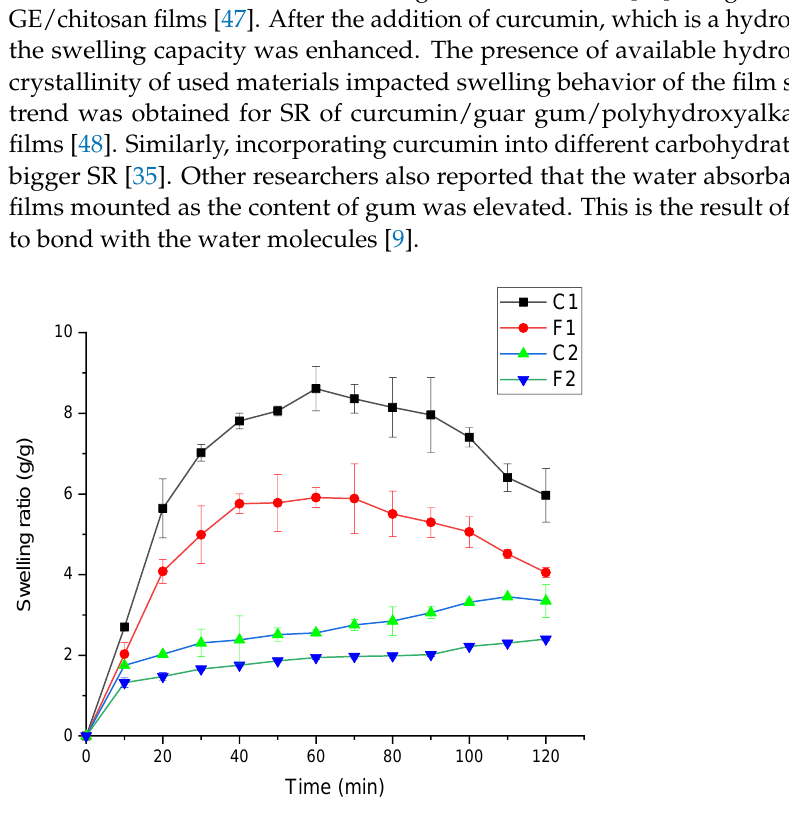
Figure 1. Swelling ratio of curcumin-loaded active film samples. F1 (1GE: 1SFTG); F2 (2GE: 1SFTG); C1 (1GE: 1 SFTG/curcumin); C2 (2GE: 1SFTG/curcumin).